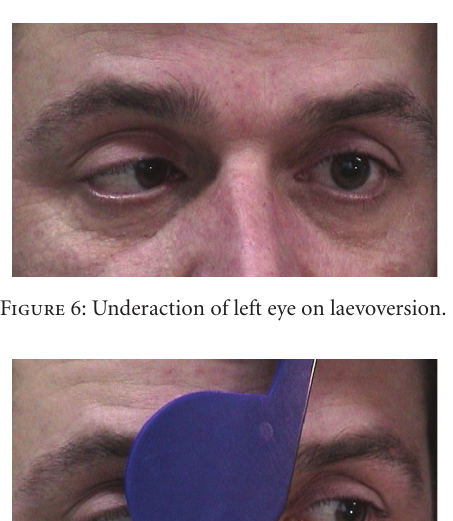
Figure 5: Left esotropia.